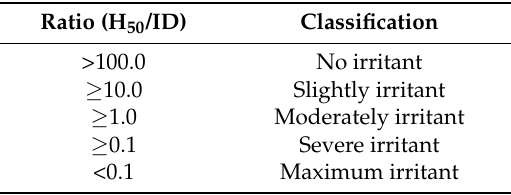
Table 3. Red blood cell (RBC) system cellular model applied to determine potential irritation of nanoemulsions